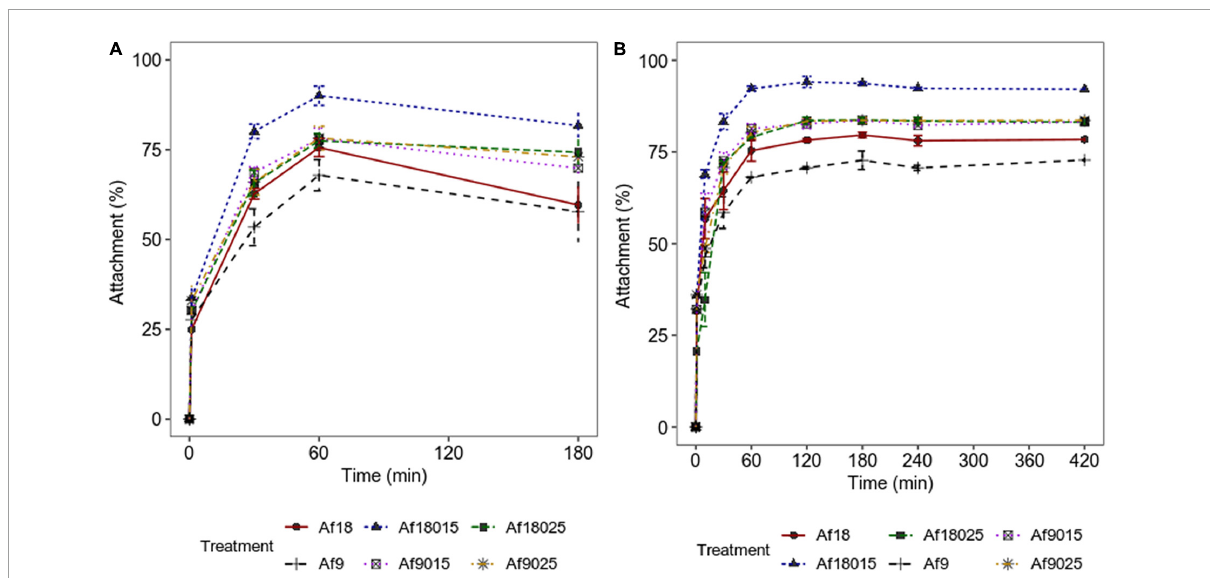
FIGURE3 Attachment kinetics of A. ferrooxidans to a polymetallic sulfide ore. (A) Data obtained by qPCR. (B) Data obtained by counting cells in the planktonic phase using a Neubauer chamber (0.02 mm). Culture modified 9K medium supplemented with 2% polymetallic sulfide ore. The data correspond to the mean values of triplicates ± SD ( n = 6).